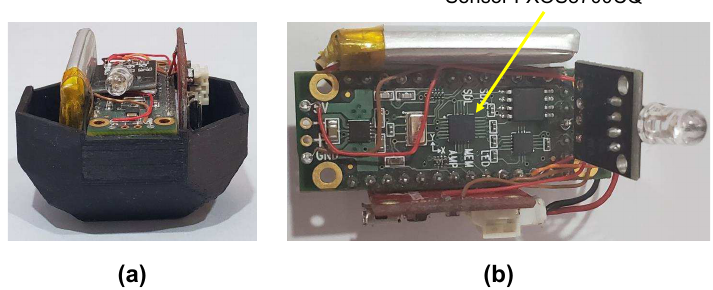
Figure 8. ( a ) small version of the proposed polyhedron; ( b ) location of sensor FXOS8700CQ in the Prop Shield sensor